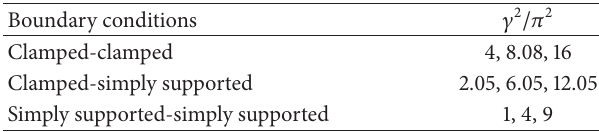
Table 1: Critical buckling loads (roots of characteristic equations) for different boundary